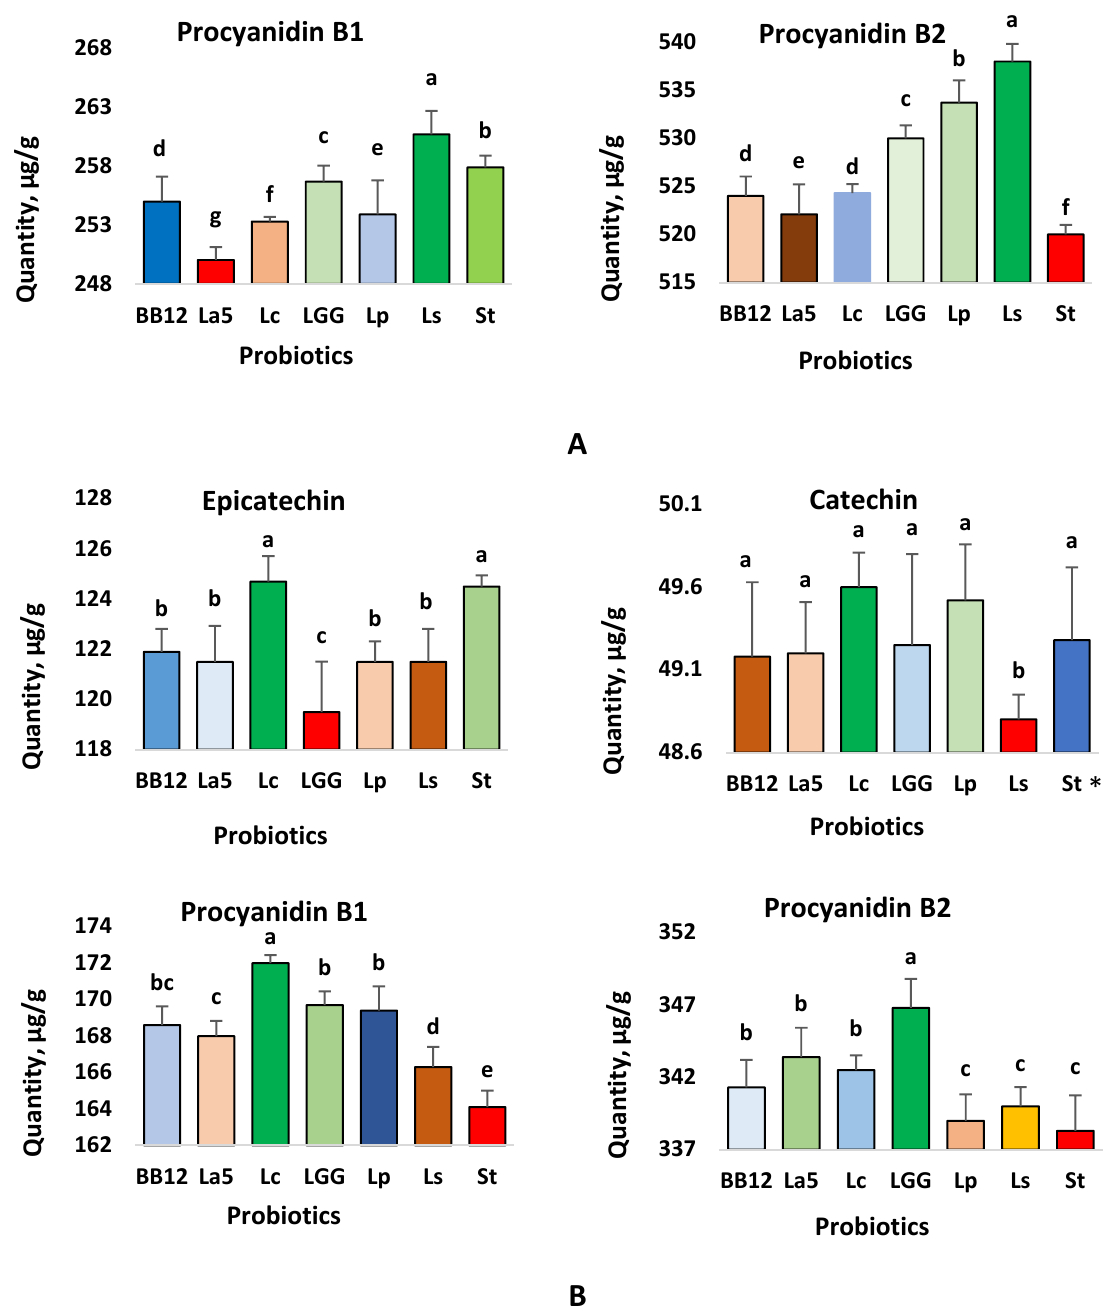
Figure 2 . Interactive effect of major polyphenols in 70% ( A ) and 45% ( B ) cocoa chocolates through simulated in vitro gastrointestinal digestion and colonic fermentation . * BB12: B. animalis spp. lactis , La5: L. acidophilus , Lc: L. casei , LGG: L. rhamnosus , Lp: L. plantarum , Ls: L. sanfranciscensis , St: S. thermophilus . Column with different lowercase letters for each polyphenol indicate statistically significant ( p < 0.01), n =